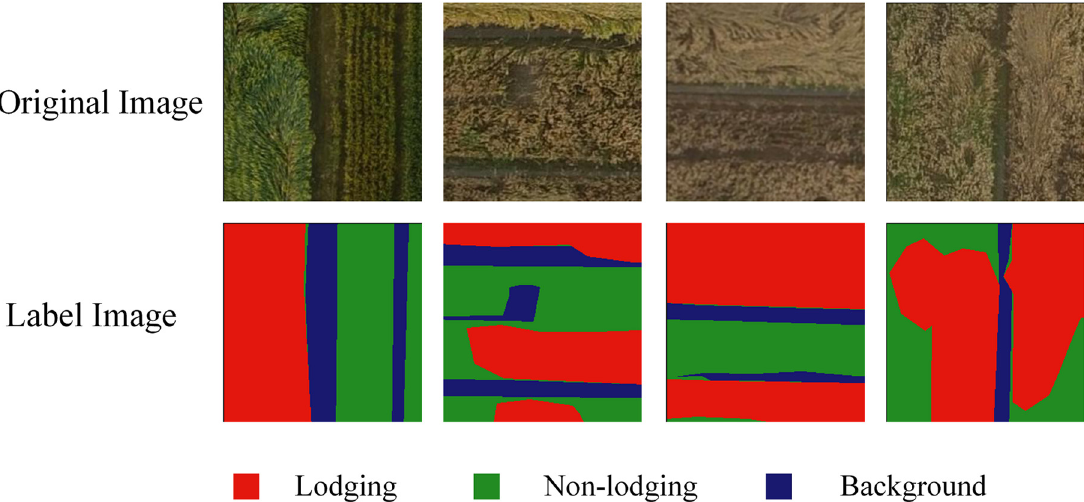
Figure 2. Example of original image and labeled image after